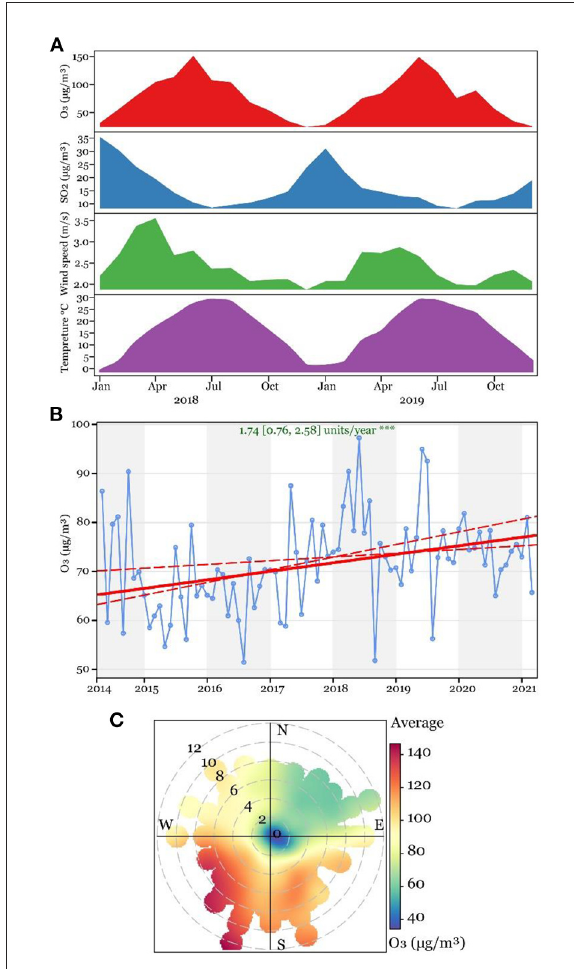
FIGURE1 Variation of ground-level ozone in Jinan between 2014 and 2021. (A) Ridge plot of ground-level ozone, sulfur dioxide, wind speed, and temperature between 2018 and 2019. (B) Theil-sen trend analysis of ground-level ozone between 2014 and 2021. (C) Variation of ozone at dimensions of different wind speeds and